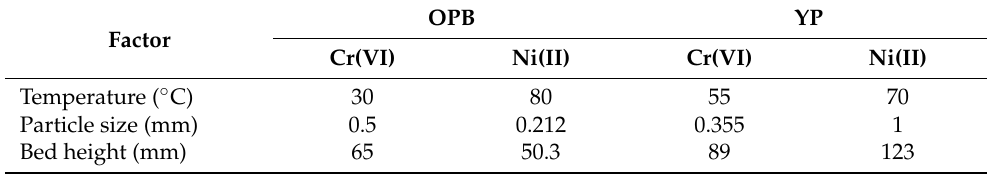
Table 5. Optimization of removal efficiency of Cr(VI) and Ni(II) over OPB and YP.